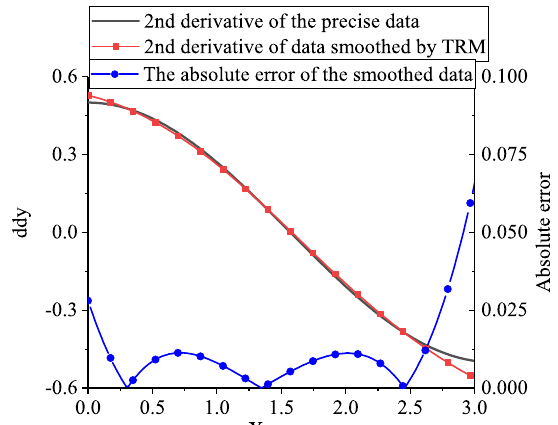
Figure A3. Compare the 2 st derivative of data between: Solid line: Precise value and red dash dot line: Smoothed by Tikhonov regulation